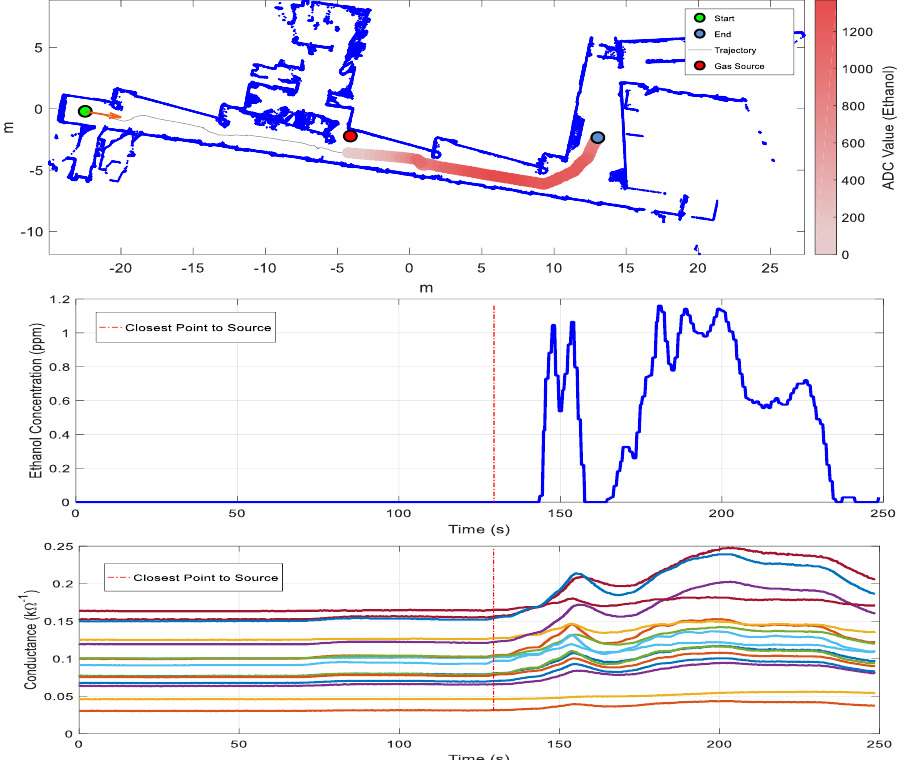
Figure 7. Results of exploration with one gas source of ethanol (Scenario I). From top to bottom: map of the arena (built by the robot) and output of the PLS-DA classifier overlaid on the robot trajectory; concentration measured by the photo-ionization detector (PID); conductance of the matrix of MOX gas sensors; output of the PLS-DA classifier and mean sensor array response (analog-to-digital converter (ADC) value) (for visual clarity, we added a threshold that indicates the mean array response during the commutation from air to ethanol). The red dotted line indicates the point of closest approximation to the gas source.